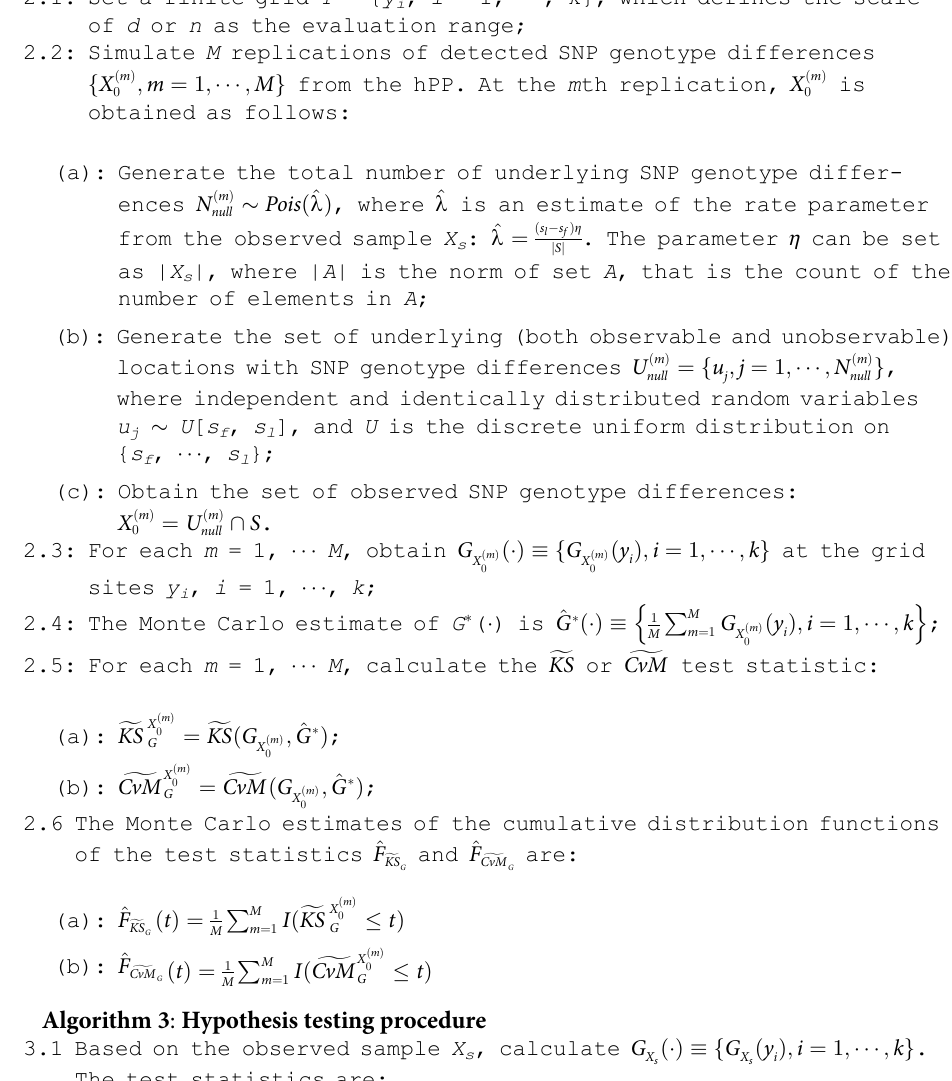
Algorithm 2 : Monte Carlo estimates of the null distributions of summary statistics